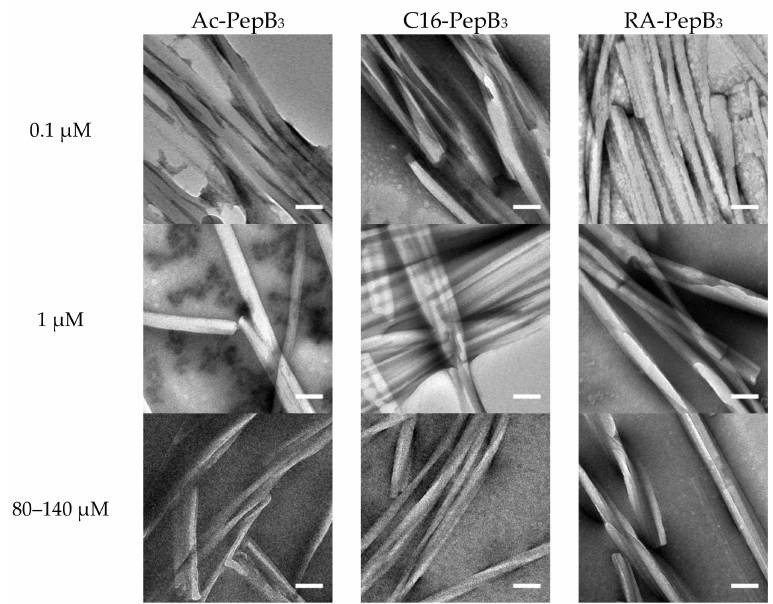
Figure 3. Transmission electron microscopy (TEM) images of PepB 3 variants. (Column 1) Ac-PepB 3 , (Column 2) C16-PepB 3 , and (Column 3) RA-PepB 3 all formed elongated micelles and 0.1 µ M (1st row,), 1 µ M (second row), and 80–140 µ M (third row) concentrations, respectively. Scale bar = 100 nm;